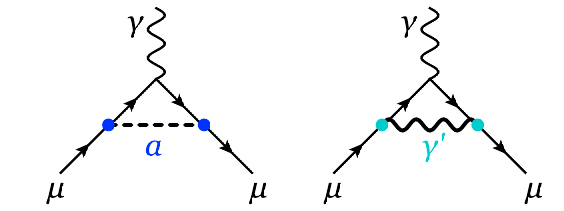
Fig. 1 The one-loop contribution to the muon anomalous magnetic moment from the dark axion portal that couples photon ( γ ), ALP ( a ), and dark photon ( γ (cid:3) )